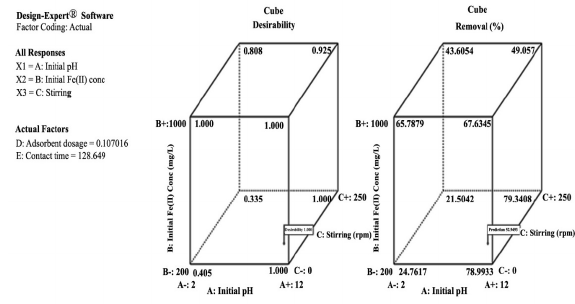
Fig. 6. Desirability and %removal.